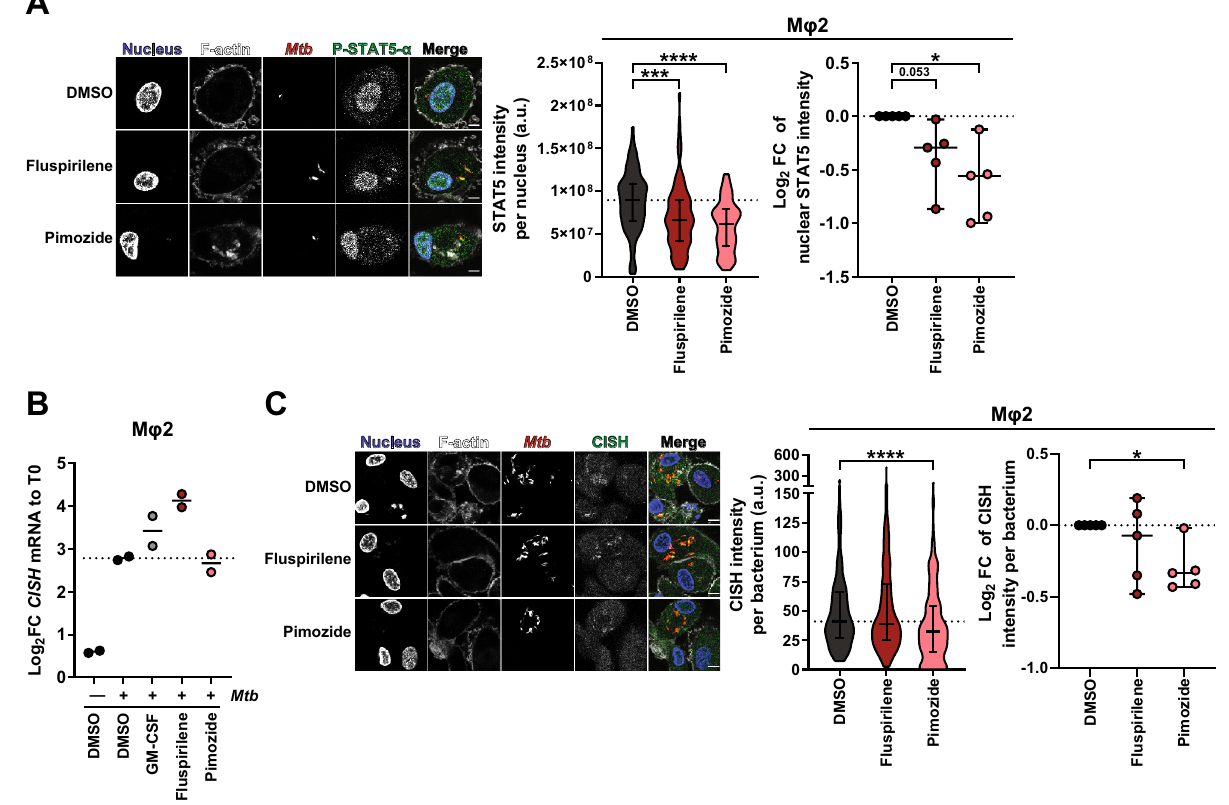
Figure 4. Fluspirilene and Pimozide inhibit STAT5 function and Pimozide additionally reduces the presence of cytokine-inducible SH2-containing protein (CISH) on Mtb phagosomes. ( A ) Confocal microscopy of DsRed- expressing Mtb -infected Mφ2 treated with 10 µM of Fluspirilene, Pimozide or DMSO at equal v/v for 4 h. Cells were fixed at the experimental endpoint, permeabilized using 0.1% Triton-X, stained for P-STAT5 and counterstained for the nucleus and F-actin using Hoechst 33,342 and Phalloidin, respectively. Shown in the left panel are representative images of Mφ2, while the middle panel shows violin plots representing all nuclei quantified (n = 73, n = 77 and n = 75 for DMSO, Fluspirilene and Pimozide, respectively) of a representative donor with median and interquartile range indicated and the right panel displays the log 2 FC of median nuclear P-STAT5 intensity per donor normalized to DMSO (5 donors in total) with median and 95% confidence intervals indicated. Scale bar annotates 5 µm. Dotted line indicates median of DMSO. Statistical significance was tested using Kruskal–Wallis test with Dunn’s multiple comparison test (middle panel) (** = p -value < 0.01, *** = p -value < 0.001 and **** = p -value < 0.0001) or RM one-way ANOVA with Dunnett’s multiple comparison test (* = p -value < 0.05). ( B ) Mφ2 derived from 2 donors were mock- or Mtb -infected and Mtb -infected Mφ2 were subsequently treated with 10 µM of Fluspirilene, Pimozide, GM-CSF (50 ng/ml) as positive control or DMSO at equal v/v for 4 h. Transcript levels of Cytokine-inducible SH2-containing protein (CISH) were determined in duplicate using qRT-PCR before (0 h baseline) and 4-h post-infection. Data was normalized to GAPDH (ΔCt). Each dot represents a single donor and displays the log 2 FC expression levels of CISH in response to treatment compared to their respective baseline control (T0) (ΔΔCt). Horizontal lines indicate median expression levels and dotted line indicates the median of Mtb -infected Mφ2 treated with DMSO. ( C ) Confocal microscopy of DsRed-expressing Mtb -infected Mφ2 treated with 10 µM of Fluspirilene, Pimozide or DMSO at equal v/v for 4 h. Cells were fixed at the experimental endpoint, permeabilized using 0.1% Triton-X, stained for CISH and counterstained for the nucleus and F-actin using Hoechst 33,342 and Phalloidin, respectively. Shown in the left panel are representative images of Mφ2, while the middle panel shows violin plots representing all bacteria quantified (n = 182, n = 179 and n = 217 for DMSO, Fluspirilene and Pimozide, respectively) of a representative donor with median and interquartile range indicated and the right panel displays the log 2 FC of median CISH integrated intensity per bacterium per donor normalized to DMSO (5 donors in total) with median and 95% confidence intervals indicated. Scale bar annotates 5 µm. Dotted line indicates median of DMSO. Statistical significance was tested using Kruskal–Wallis test with Dunn’s multiple comparison test (middle panel) (**** = p -value < 0.0001) or RM one-way ANOVA with Dunnett’s multiple comparison test (* = p -value <